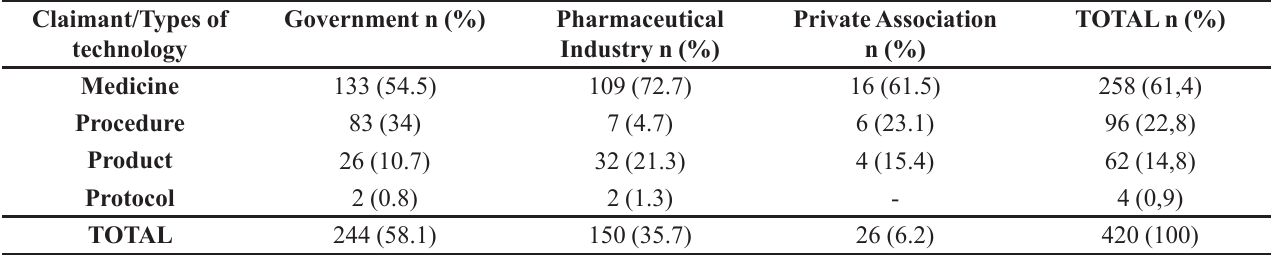
TABLE I - Types of technology distribution according to the claimant qualifications. January 2012 - July 2015, Brazil Claimant/Types